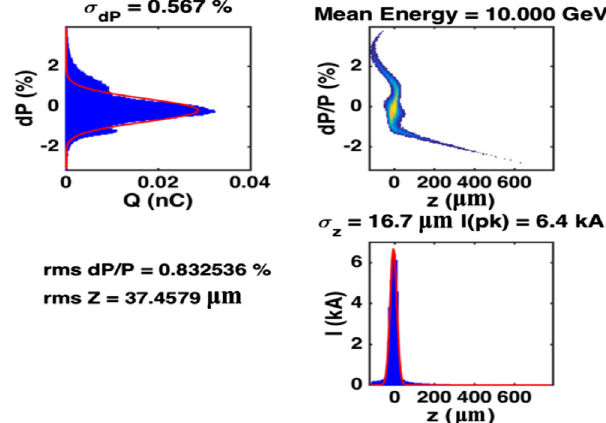
FIG. 6. Longitudinal phase space of the 2-nC bunch tracked to sector 20 at limited to 6 kA peak current compression.